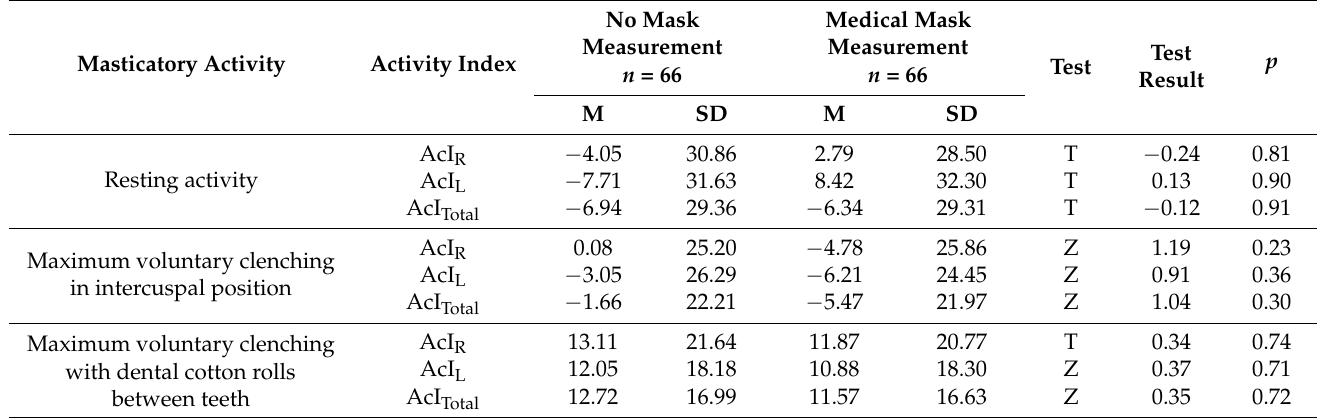
Table 3. The comparison of the mean activity index (AcI) between no mask and medical mask